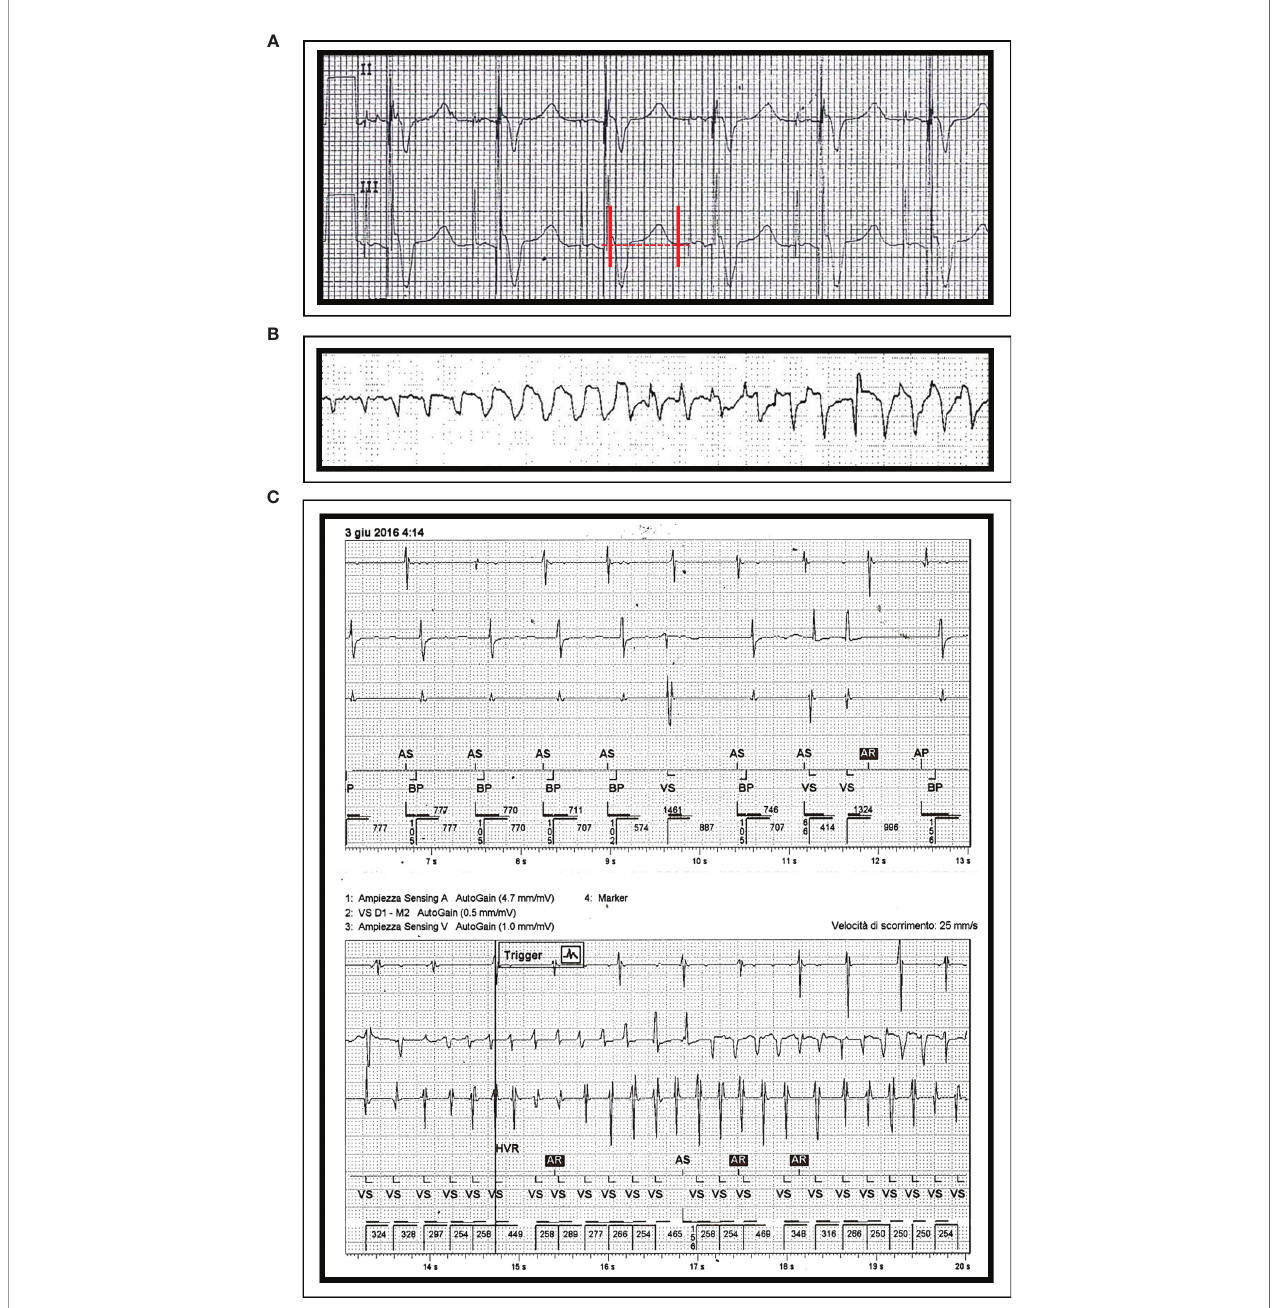
FIGURE 3 | ECG fi ndings in patient 3: (A) QTc prolongation (530 ms) during paced rhythm (QRS 200 ms). Episodes of Torsades de Pointes, as recorded by ECG monitoring (B) and by interrogating the PM (C) . Red vertical lines in lead III show the QT